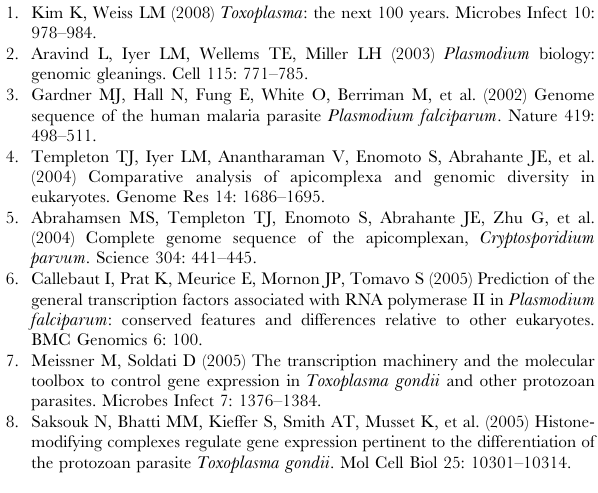
Table S2 Oligonucleotide primers used for construction of ENO1 targeting vector. Table S3 Oligonucleotide primers used for validation of ENO1 deletion. Table S4 Identification of T. gondii genes and promoters defined by genome-wide TgENO2 occupancy and ChIP-Seq. The list of gene targets was obtained using bioinformatics analyses and genome data from http://www.toxodb.org. After comparison of data from three independent experiments only genes that were identified in ChIP using anti-TgENO2 and anti-HA are shown. Genes that were non-specifically pulled down by the naı¨ve sera used as a negative control were removed. Table S5 Identification of T. gondii genes and ORFs defined by genome-wide TgENO2 occupancy and ChIP-Seq. The list of gene ORF targets was obtained using bioinformatics analyses and genome data from http://www.toxodb.org. After comparison of data from three independent experiments only genes that were identified in ChIP using anti-TgENO2 and anti-HA are